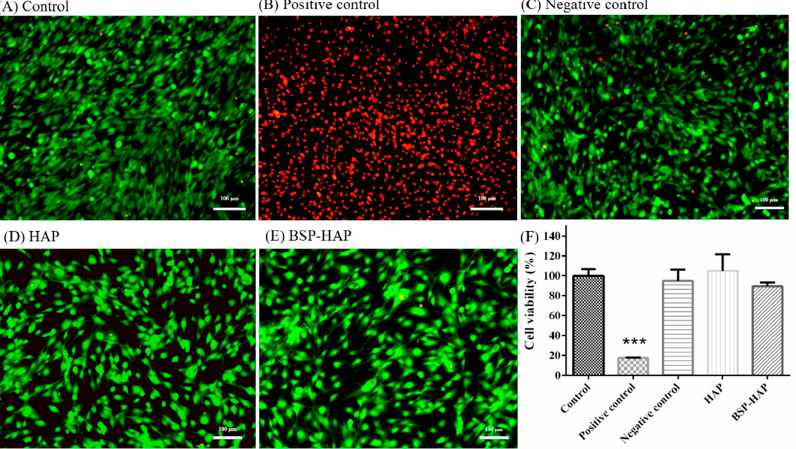
Figure 6. Cytotoxicity assay of BSP-HAP by using LIVE/DEAD staining. ( A ) Control group, ( B ) posi- tive control, ( C ) negative control, ( D ) HAP, and ( E ) BSP-HAP. ( F ) Cell viability evaluation of BSP-HAP by WST-1 assay. C2C12 cultured in DMEM was set as the control group ( n = 6, *** p < 0.001 compared with control). Zinc diethyldithiocarbamate and aluminum oxide served as positive control and negative control,